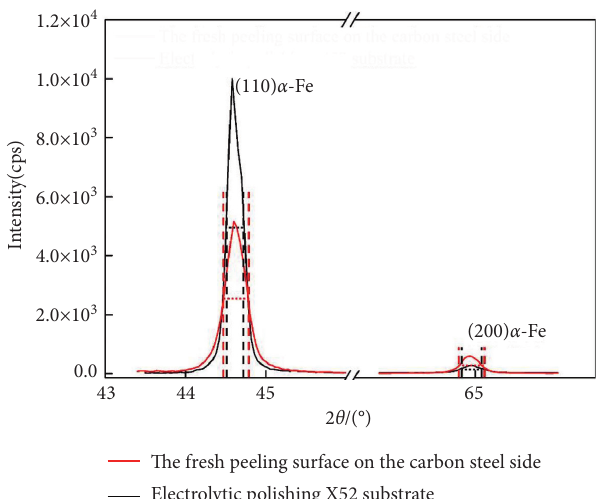
Figure 5: XRD patterns of electrolytic polishing X52 substrate and the fresh peeling surface on the carbon steel side. Table 2: FWHM of fresh revealed peeling surface on the carbon steel side and electrolytic polishing X52 substrate. Samples 2 θ / ° (h k l) The fresh revealed peeling surface on the carbon steel side